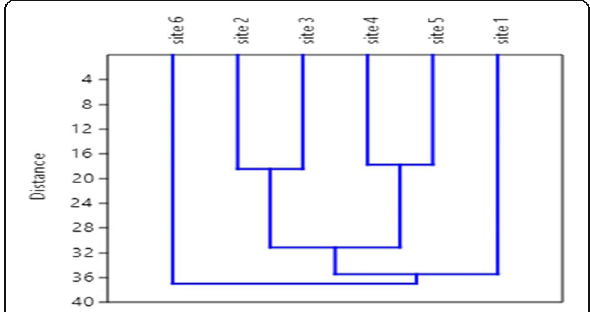
Fig. 3 Dendrogram illustrating similarities in aquatic insect assemblages between the six study